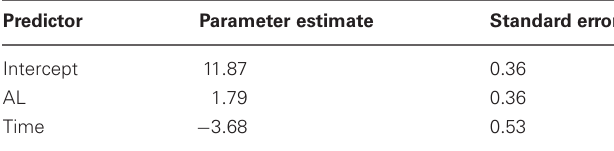
Table 10 | Parameter estimates for the significant